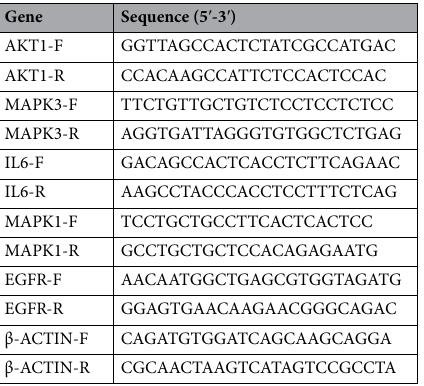
Table 1. Real-time polymerase chain reaction primers.